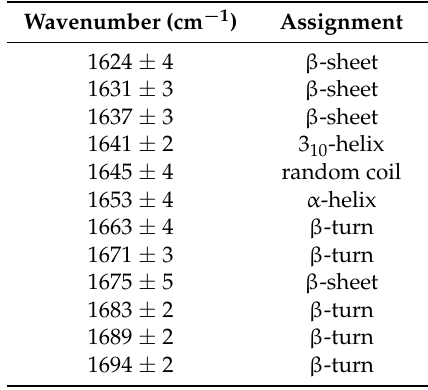
Table 2. Deconvoluted amide I band frequencies and assignments to protein secondary structure in D 2 O [13].